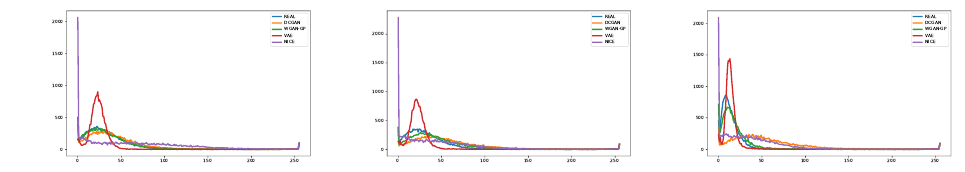
Figure 23. Gray histogram results of four simulated images, and the real image. From left to right: